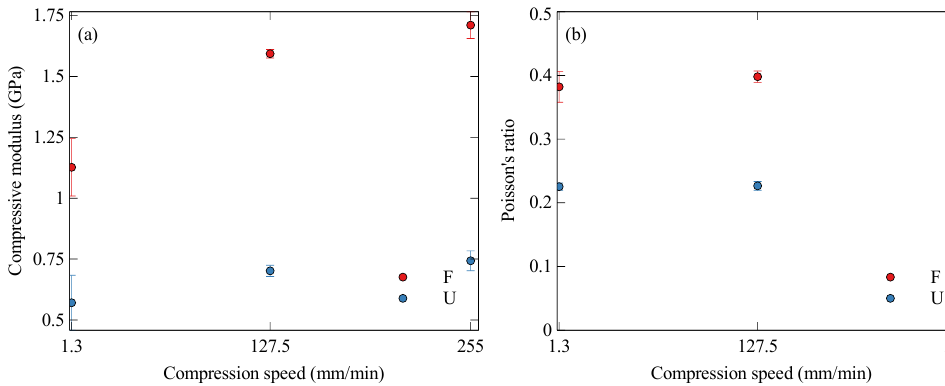
Figure 10. Variation of compressive properties of Onyx with strain rate and orientation: ( a ) compres- sive modulus and ( b ) Poisson’s ratio for flat (F) and upright (U) specimens.